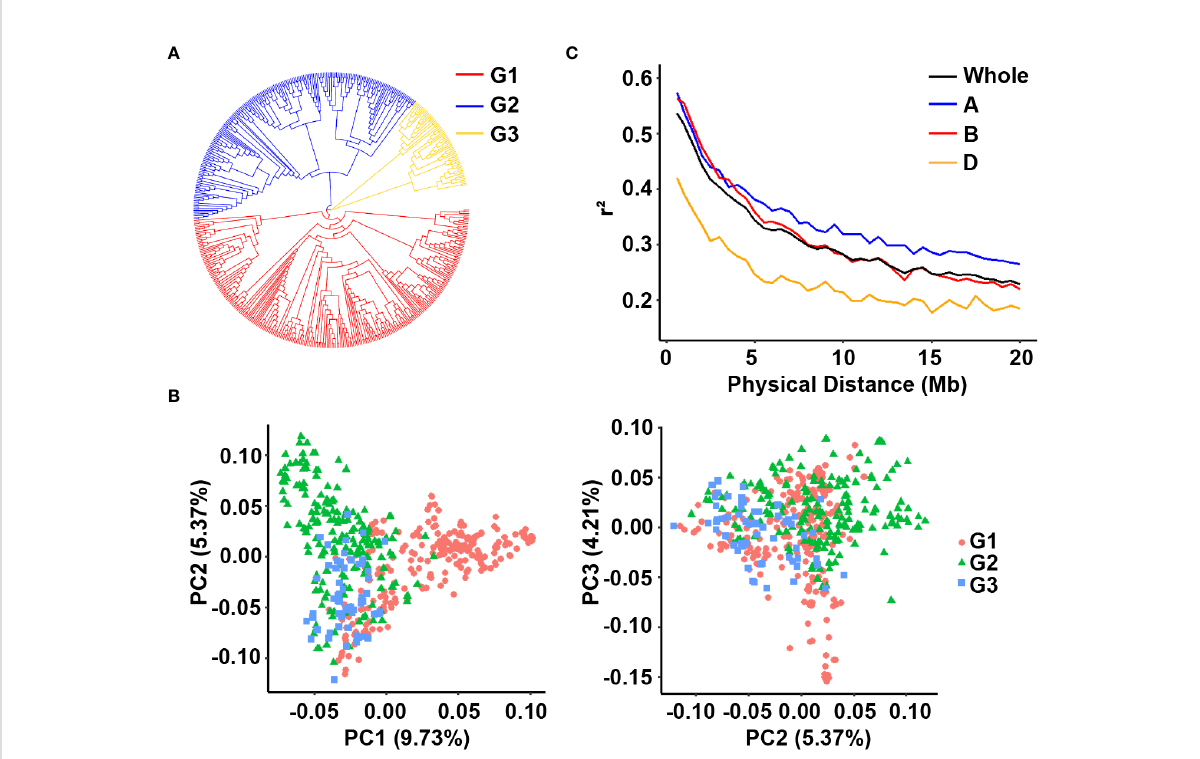
FIGURE 3 Analysis of the population structure of the 502 wheat accessions. (A) Neighbor-joining tree of all wheat accessions; (B) Principal component analysis showing the population structure in the diversity panel; (C) LD decay value in the whole genome, A sub-genome, B sub-genome and D sub-genome of